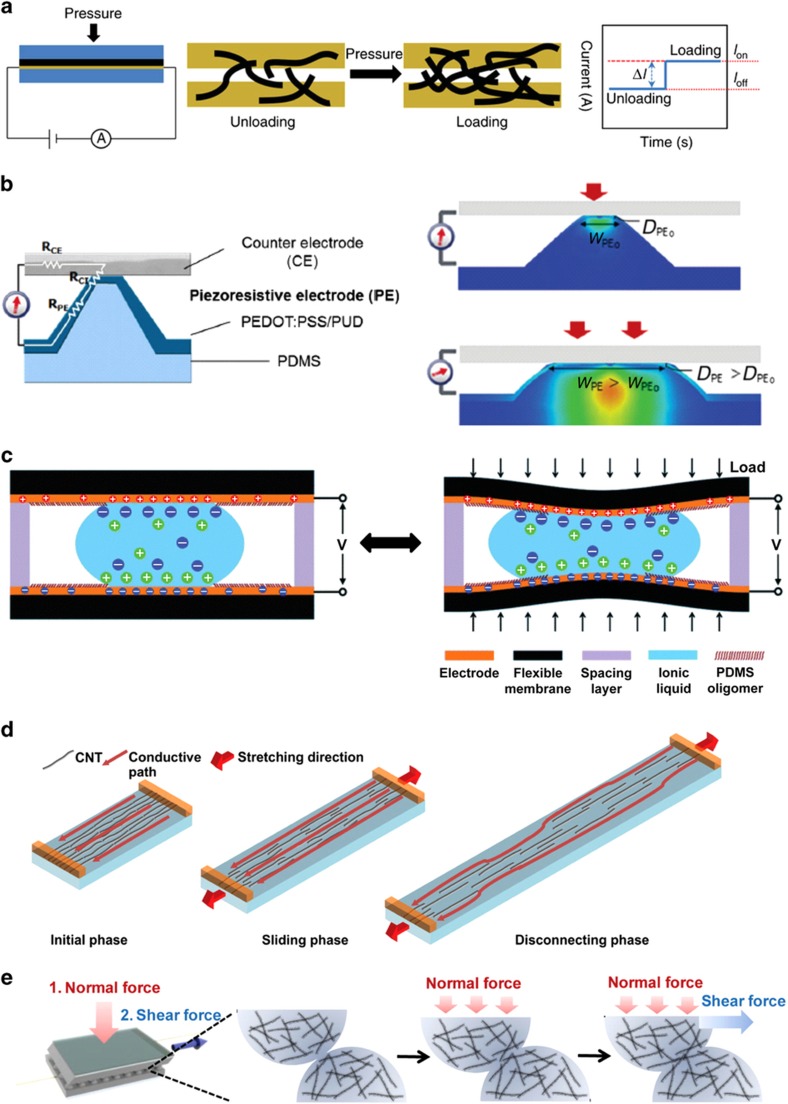
Deformation-based physical sensing mechanisms. (a) AuNW-coated tissue paper-based pressure sensor. Schematic illustration depicting the pressure-induced deformation-based working mechanism of the sensor. Adapted with permission from Ref. 3. Copyright 2014 Macmillan Publishers Limited. (b) Micropyramid-based stretchable resistive pressure sensor. Schematic illustration showing the circuit model describing the pressure-induced deformation-based sensing principle of the device and the finite element analysis illustrating the distribution of stress on the micropyramid-based electrode upon the application of external pressure. Adapted with permission from Ref. 17. Copyright 2014 Wiley-VCH Verlag GmbH & Co. (c) Iontronic microdroplet array (IMA) flexible tactile sensor. Schematic illustration showing the interfacial capacitive sensing principle of the IMA flexible tactile sensor. Adapted with permission from Ref. 105. Copyright 2014 The Royal Society of Chemistry. (d) CNT-based elastic strain sensor. Schematic illustration showing the operating principle of the CNT fiber-based strain sensor under different strain regimes. Adapted with permission from Ref. 70. Copyright 2015 American Chemical Society. (e) Skin-inspired interlocked microdome array-based tactile sensor. Schematic illustration showing the normal and shear force detection capability of the interlocked microdome arrays based on the distinct surface deformation of the microdomes upon the application of different forces. Adapted with permission from Ref. 7. Copyright 2015 American Chemical Society.